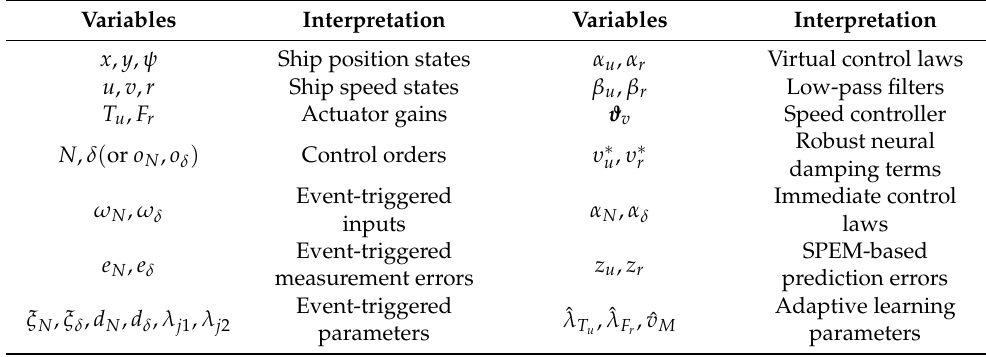
Table 1. Interpretation of the key